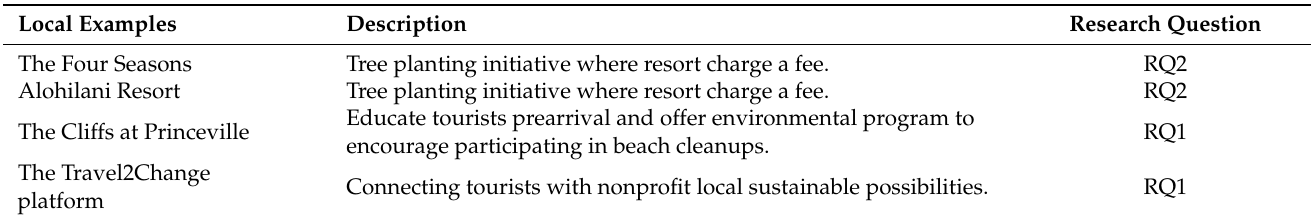
Table 5. Local examples of nature-based